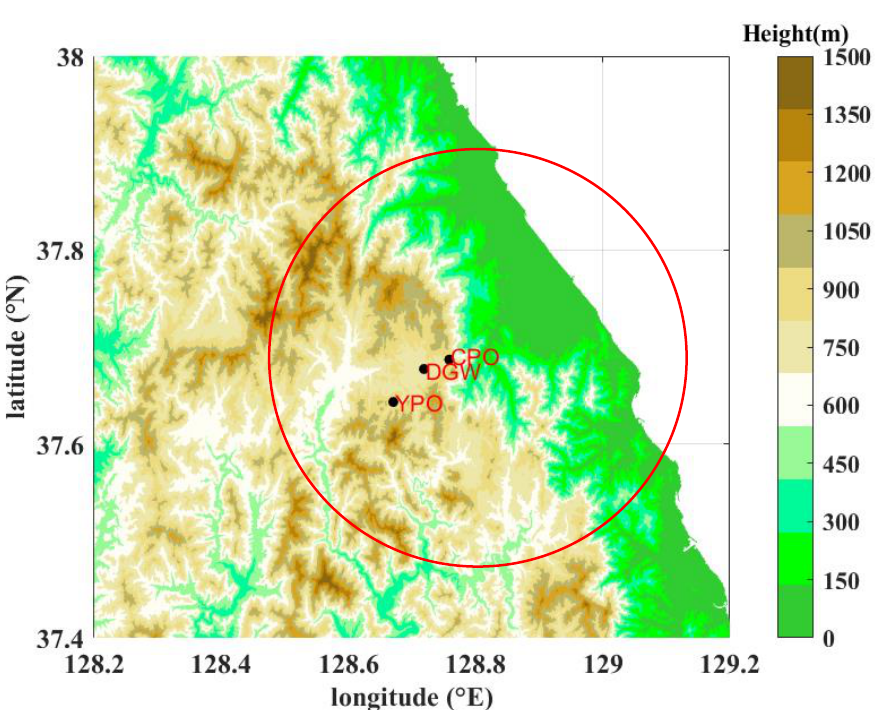
Figure 1. Location of Pyeongchang and the deployment of D3R and Parsivel disdrometers at three sites. D3R radar is deployed at the DGW site, and the red circle with a radius of 40 km is its coverage. Parsivel disdrometers were located at the YPO, CPO and DGW sites.